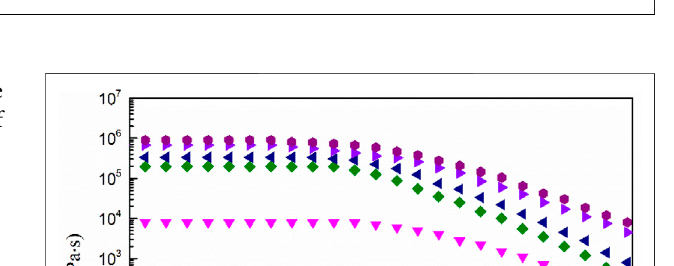
FIGURE 2 | Mass spectrum of MSA.